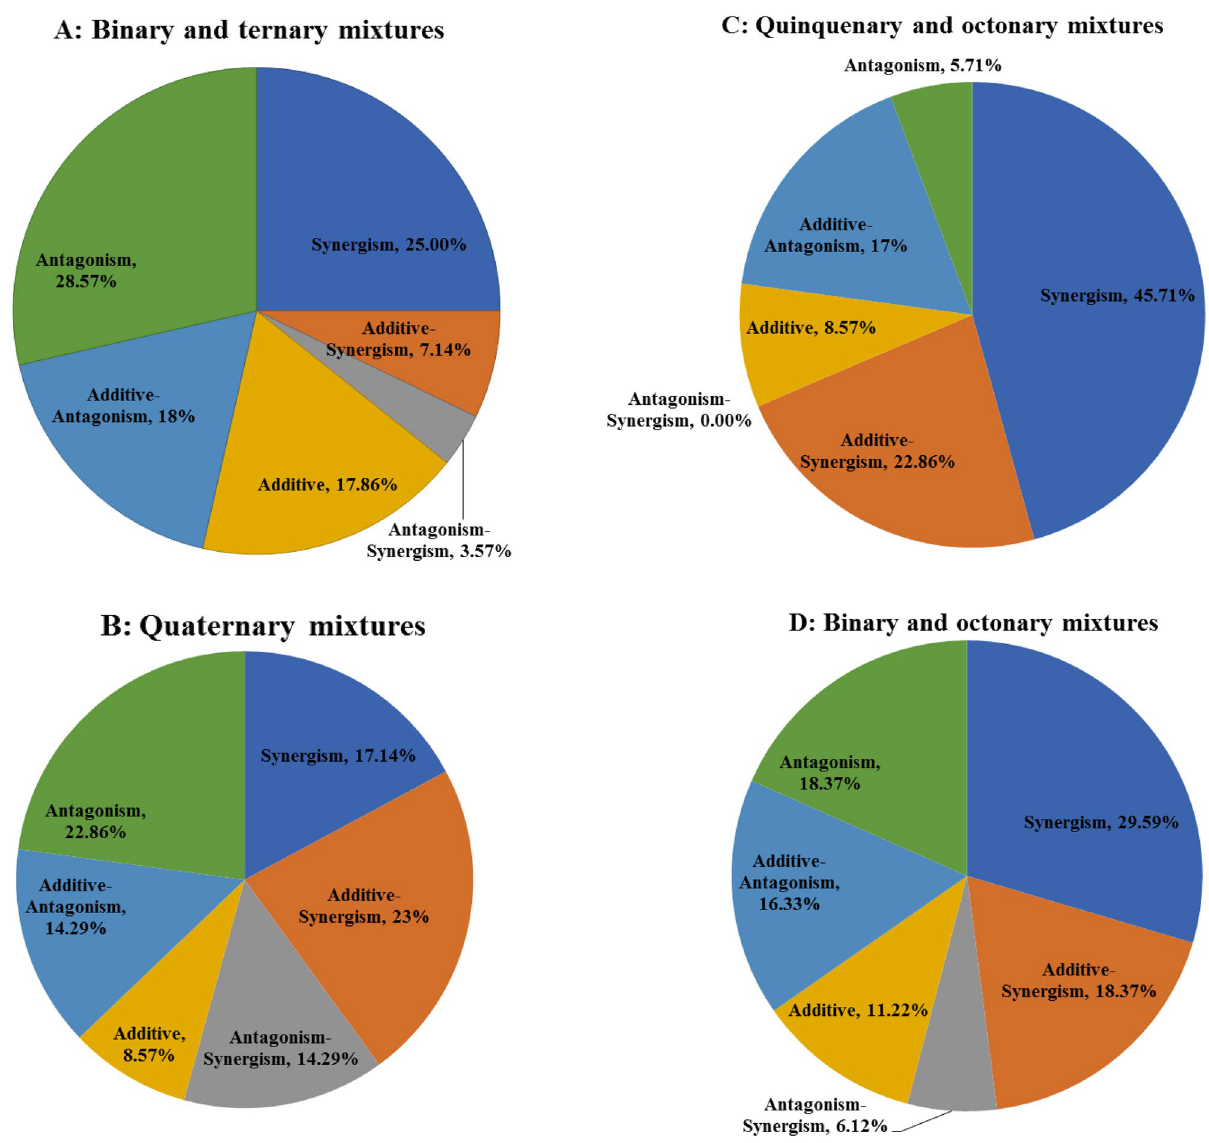
Figure 5. Interaction patterns of thiamethoxam (THI) mixed with seven pesticides on honey